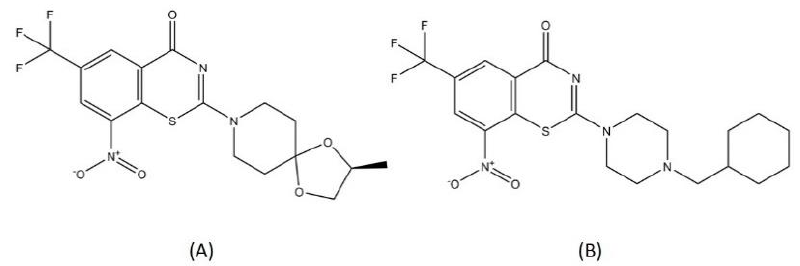
Figure 8. Structure of ( A ) BTZ-043 and ( B ) macozinone.